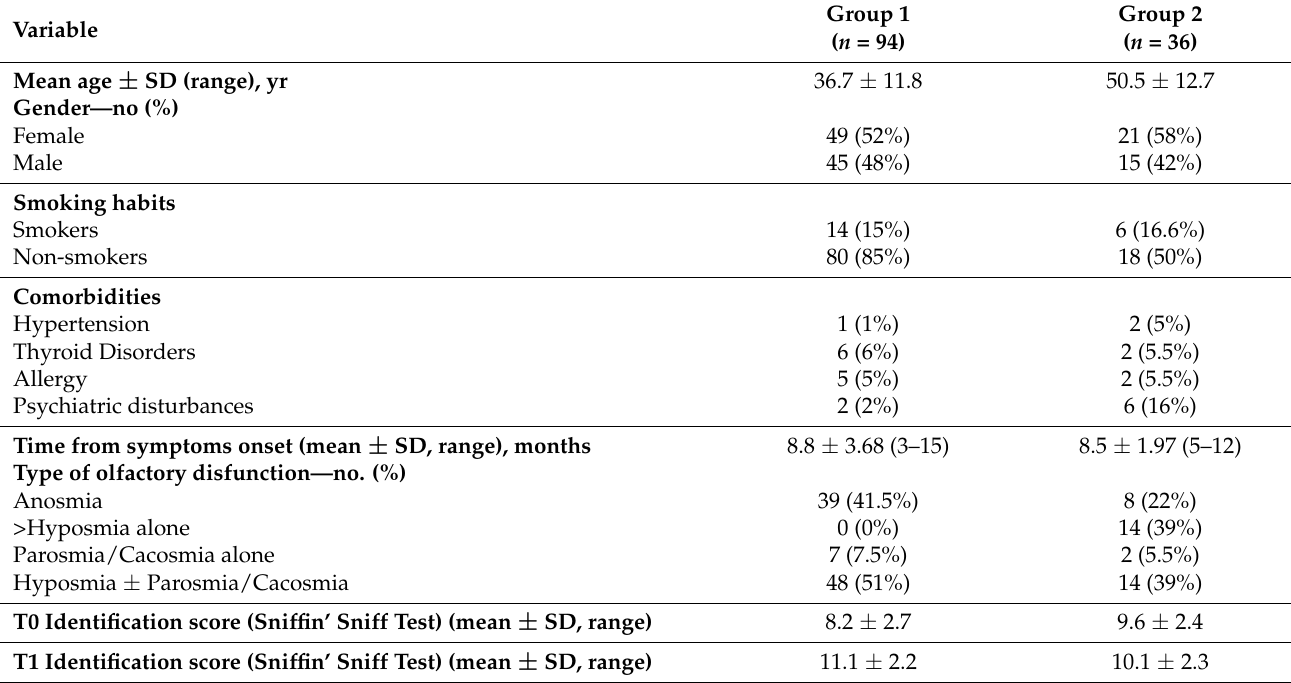
Table 1. Characteristic of patients of patients included in the